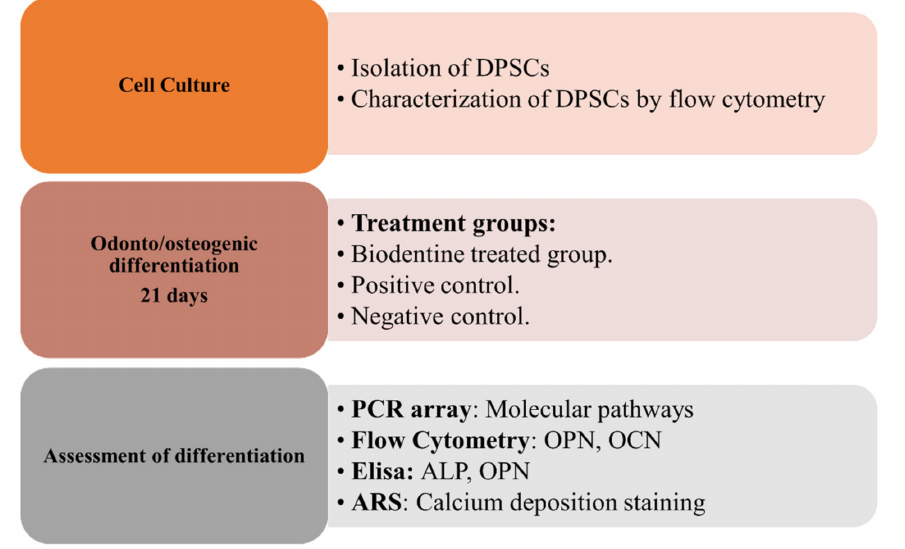
Figure 1. Flow chart of work